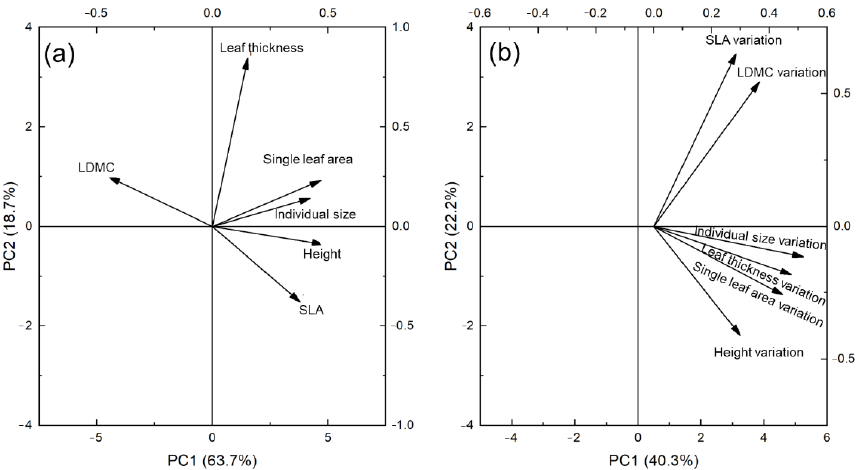
Figure 2. PCA analysis of trait mean ( a ) and variation ( b ) for SLA, LDMC, single leaf area, leaf thickness, height, and individual size.